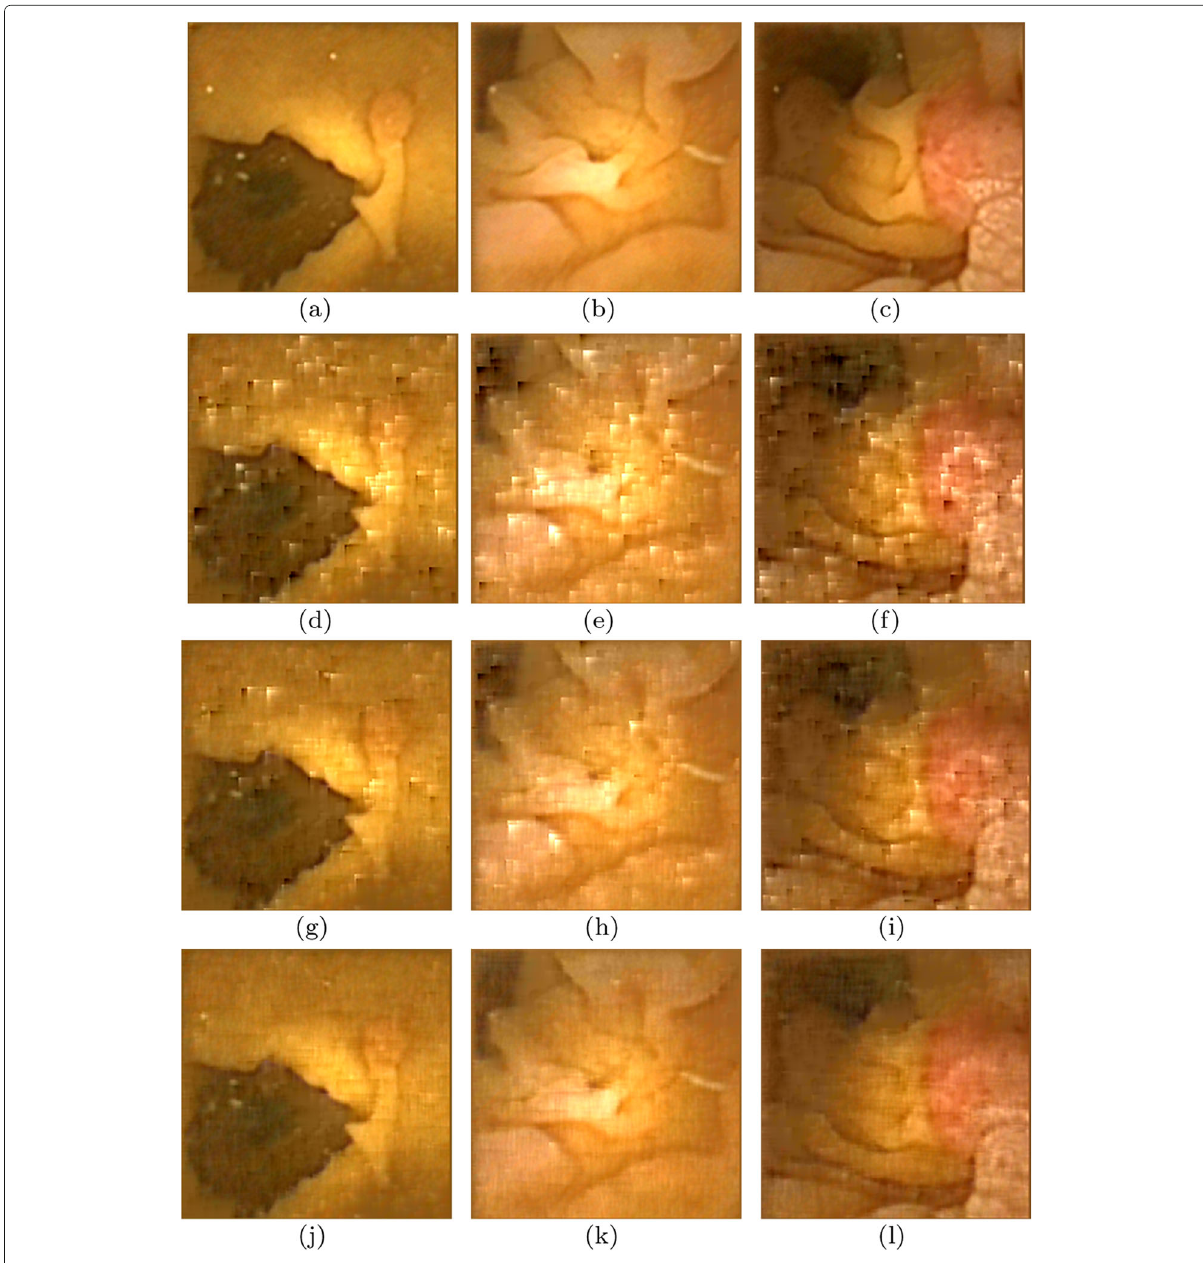
Fig. 12 Selection of compressed images used during SSIM calculation. a Compressed image 1. b Compressed image 2. c Compressed image 3. d Noisy image 1, SSIM = 0.745. e Noisy image 2, SSIM = 0.794 f Noisy image 3, SSIM = 0.751. g CD image 1, SSIM = 0.796. h CD image 2, SSIM = 0.827. i CD image 3, SSIM = 0.790. j TV + CD image 1, SSIM = 0.848. k TV + CD image 2, SSIM = 0.846. l TV + CD image 3, SSIM =